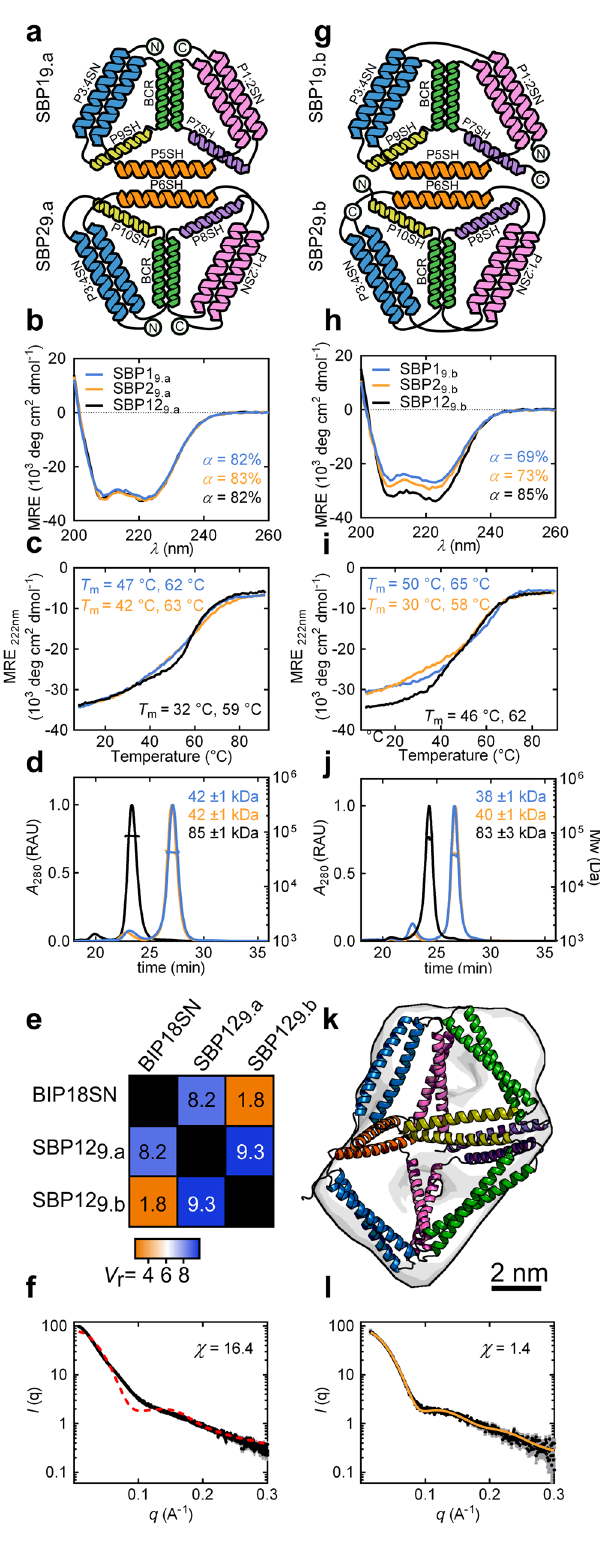
Solution structure of the complex SBP12 9.a was investigated with SAXS. The measured scattering pro fi le fi t poorly to a bipyramidal cage model and lacked the maximum at 0.14 Å − 1 that was observed for the single-chain design (Fig. 3e, f). Moreover, experimentally determined D max of 20.0 ± 1.0 nm and R g of 5.3 ± 0.2 nm, differed signi fi cantly from those observed for BIP18SN (Supplementary Fig. 3a and Supplementary Table 2). Ab initio reconstruction of the molecular envelope from SAXS data suggested that the complex assumed a partially collapsed conformation, lacking an internal cavity (Supplementary Fig. 4b), distinct from the conformation adopted by the single-chain